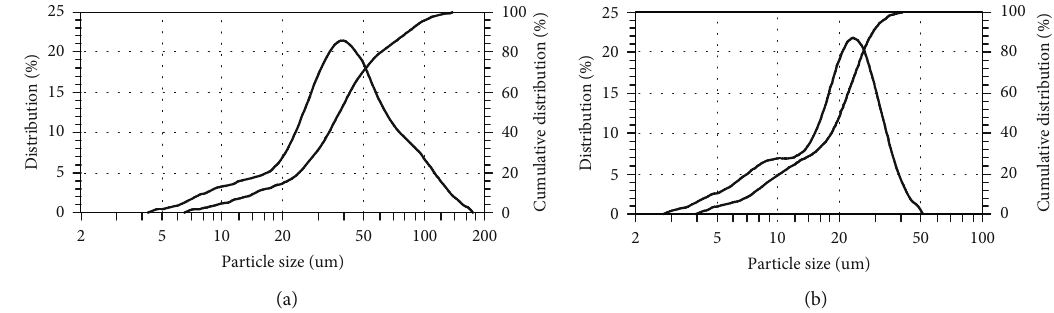
Figure 5: Particle size distribution of (a) waste-soil and (b) binder.